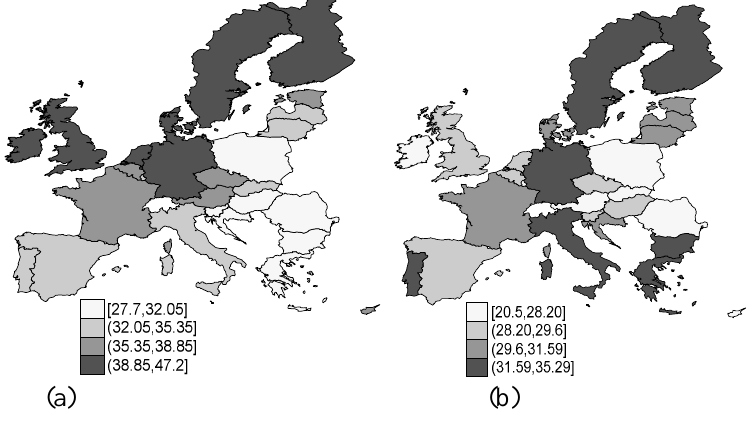
Figure 1. The ageing indicators, across the EU–28, 2018: a) AAI; b) ODR